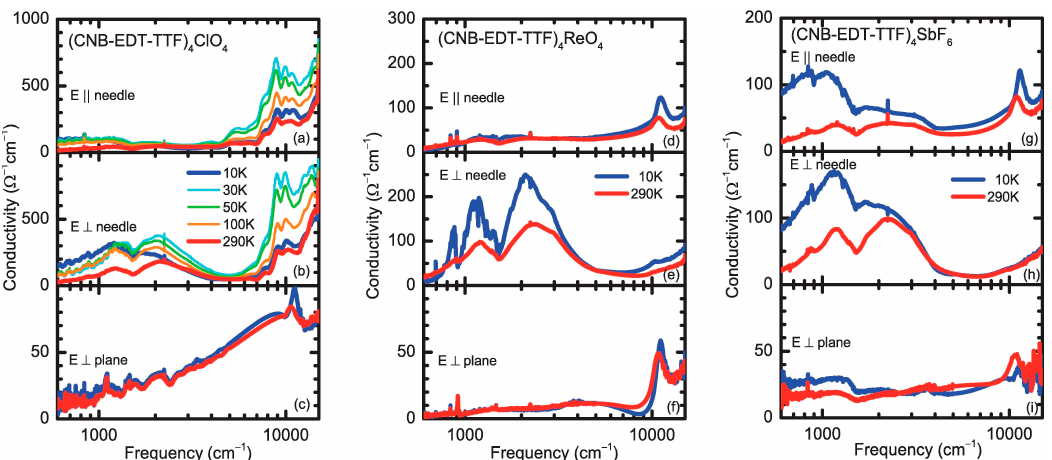
Figure 5. Overall picture of the optical conductivity of (CNB-EDT-TTF) 4 ClO 4 (panels a – c ), (CNB-EDT-TTF) 4 ReO 4 (panels d – f ), and (CNB-EDT-TTF) 4 SbF 6 (panels g – i ) for the three directions obtained from reflectivity measurements at different temperatures, as indicated. Note the logarithmic scale in frequency and the different axes of ordinates.